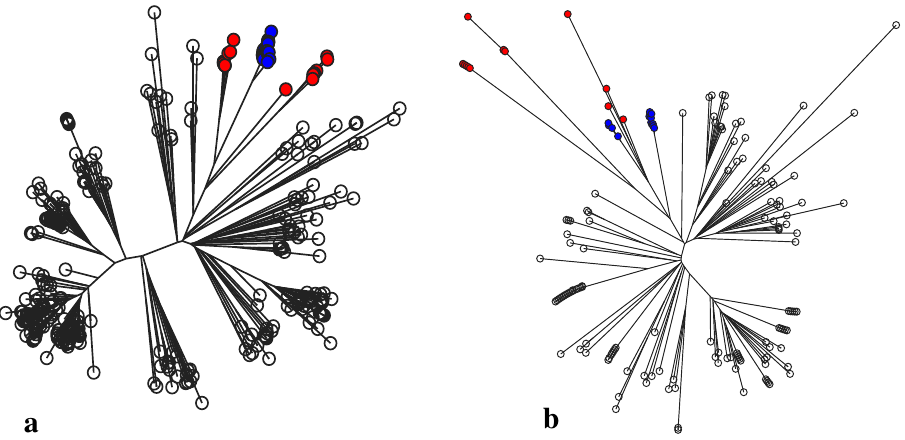
a b Figure 1. Phylogenies based on an alignment of S. aureus core genes from CC1 isolates ( a ) and CC188 isolates ( b ). Isolates from bats in captivity are shown in blue, isolates from free-ranging bats are shown in red. Other branches correspond to lineages from public databases. These trees are available to explore on Microreact: ( a ) https:// micro react. org/ proje ct/ fz62Z cddcf Jmv7A aAhTG ut-s- aureus- st1- in- livin gston es- bats. ( b ) https:// micro react. org/ proje ct/ qSKkp azZp7 qpeGW tSY9o cg-s- aureus- cc188- in- livin gston es-